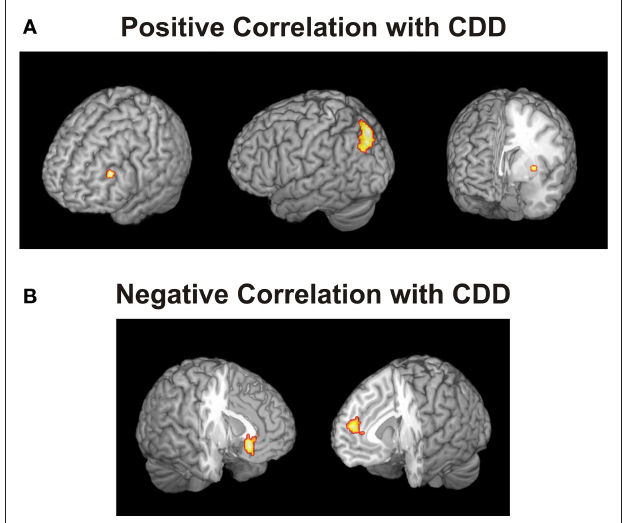
Figure 3 | Areas whose activity was positively or negatively correlated with the context-dependent desirability (CDD) of the chosen gamble. The CDD quantified the subjective desirability of a gamble, given the other gamble presented, and was defined as the log odds of choosing gamble X when paired with gamble Y . (A) Activity in DLPFC (peak at MNI coordinates: − 42, 36, 27), posterior parietal cortex ( − 21, − 81, 48) and putamen ( − 33, − 3, 0) were positively correlated with CDD, (B) activity in ventromedial ( − 6, 27, − 12) and medial prefrontal cortex (9, 51, 15) was negatively correlated with CDD. Threshold p < 0.001, minimum five